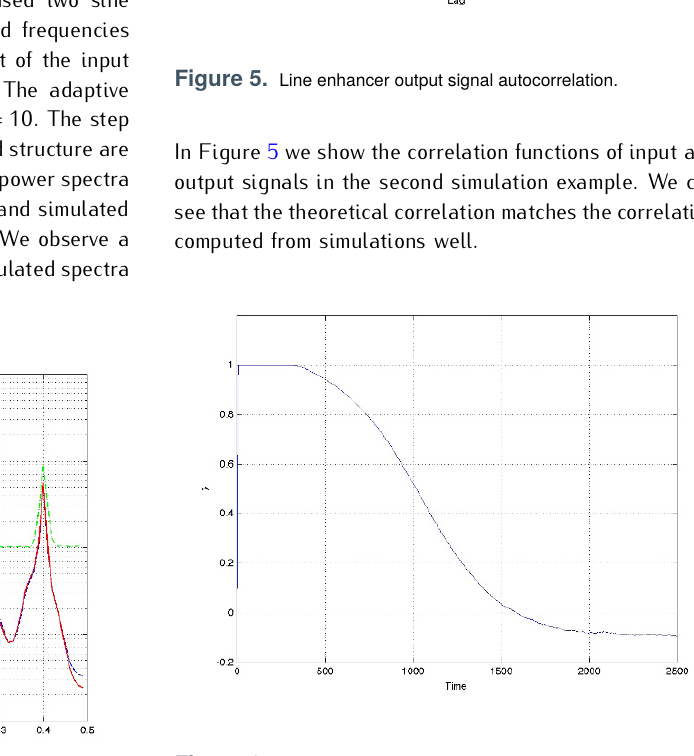
Figure 6. Evolution of λ in